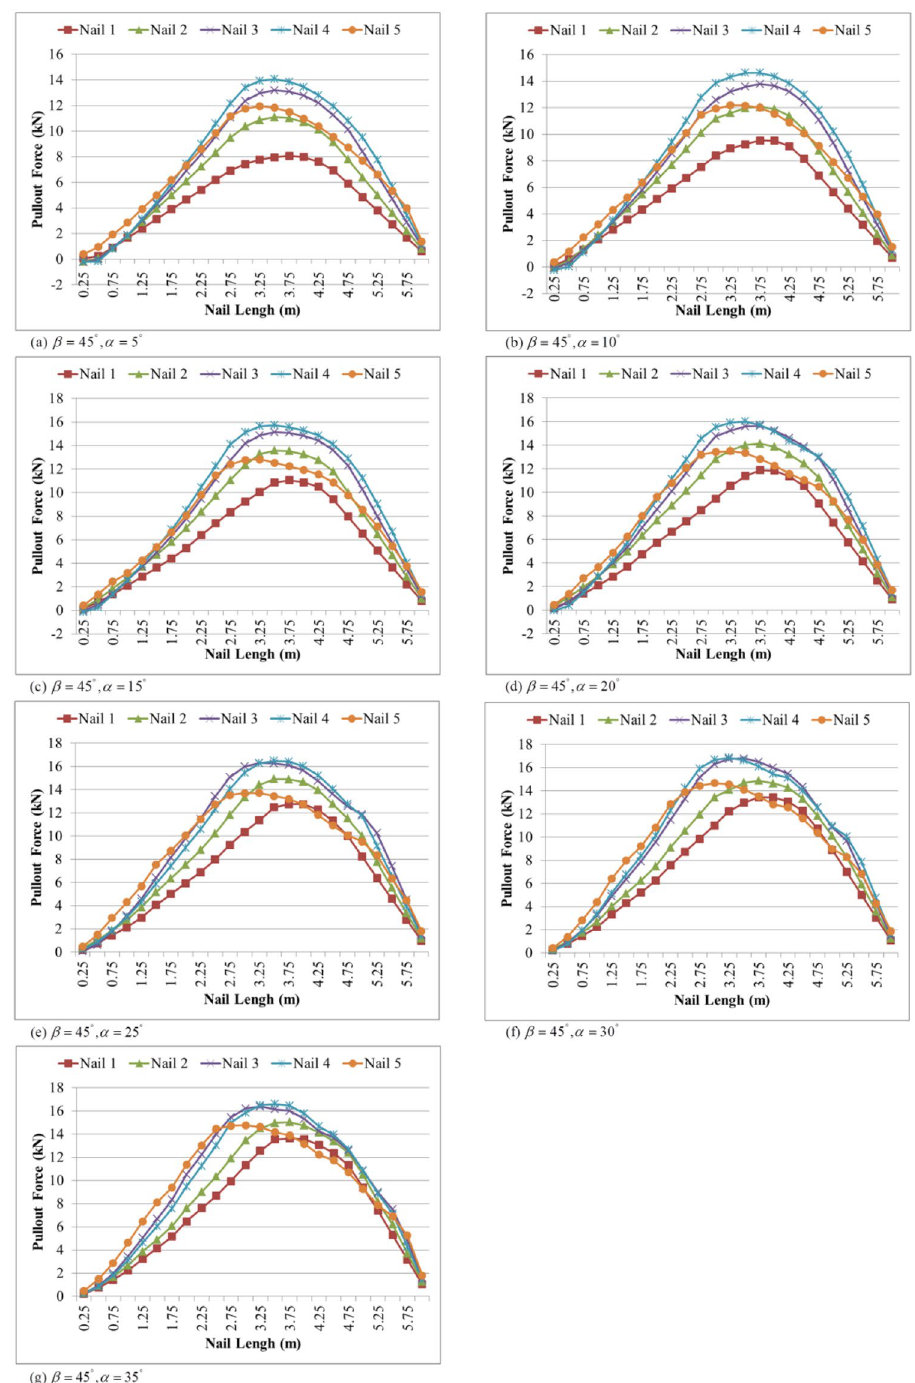
Fig. 7 Plots of the maximum pull-out force of nails in terms of the nail length with nails installed in the slope which has an angle of β = 45°, and at dif- ferent angles ( α = 5° to α =